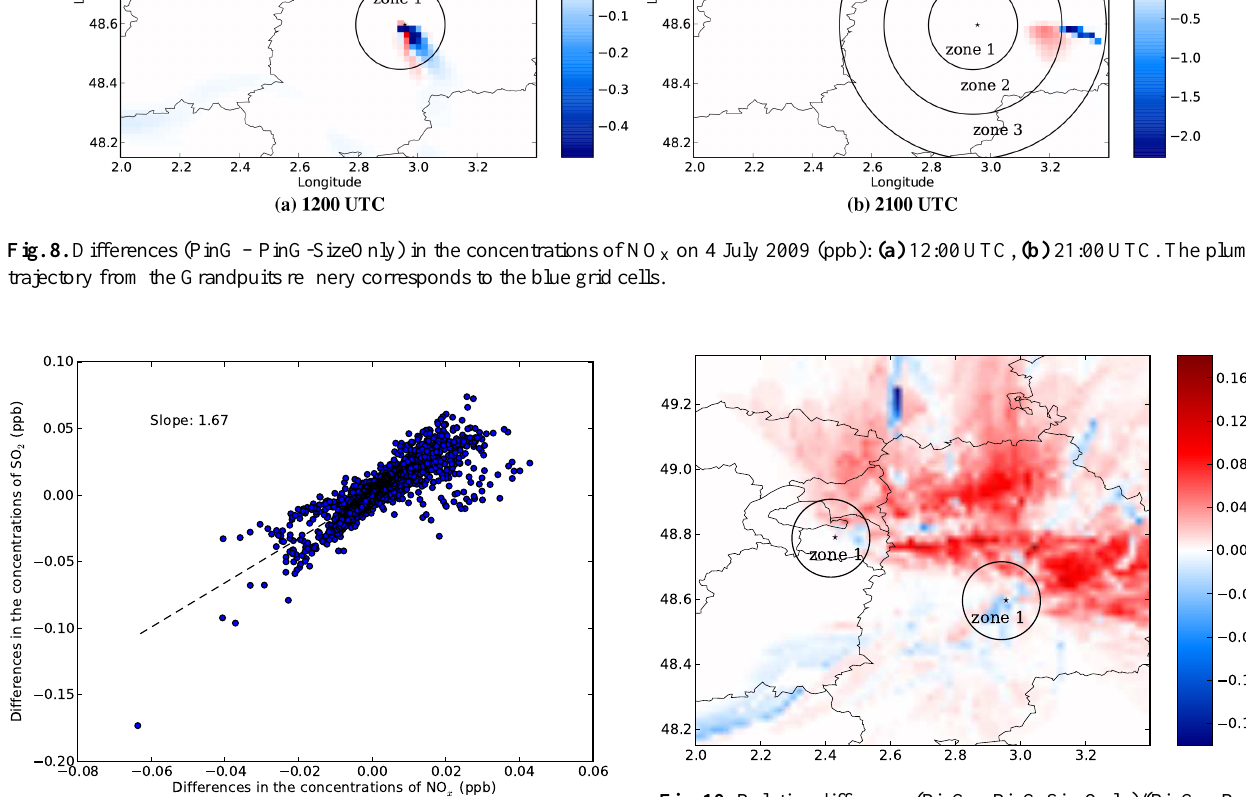
Fig. 9. Scatter diagram of differences (PinG – PinG-SizeOnly) in the mean concentrations of NO x and SO 2 for 4–29 July 2009 over all grid cells of the Greater Paris domain (ppb).